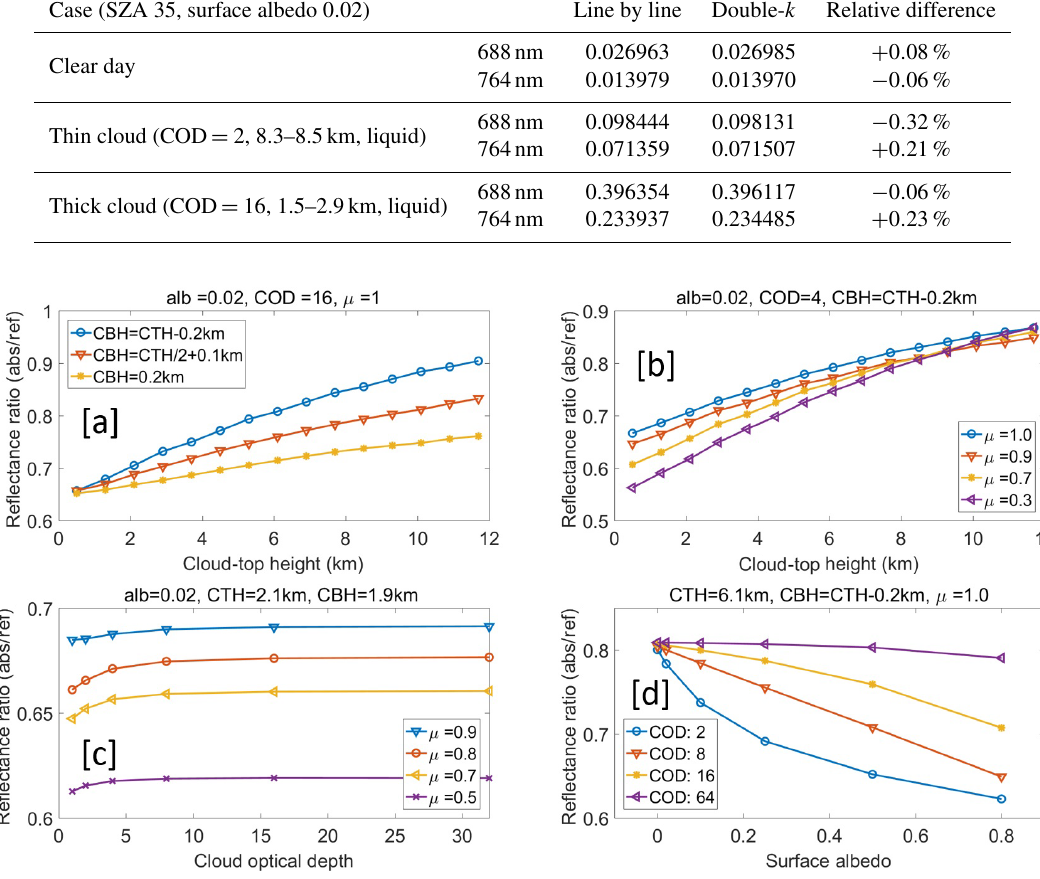
Figure 3. Ratio of simulated reflectance measurements for the EPIC B-band to B-band reference with different surface albedo (alb), COD, µ (cosine of solar zenith angle), cloud-top height (CTH), and cloud-bottom height